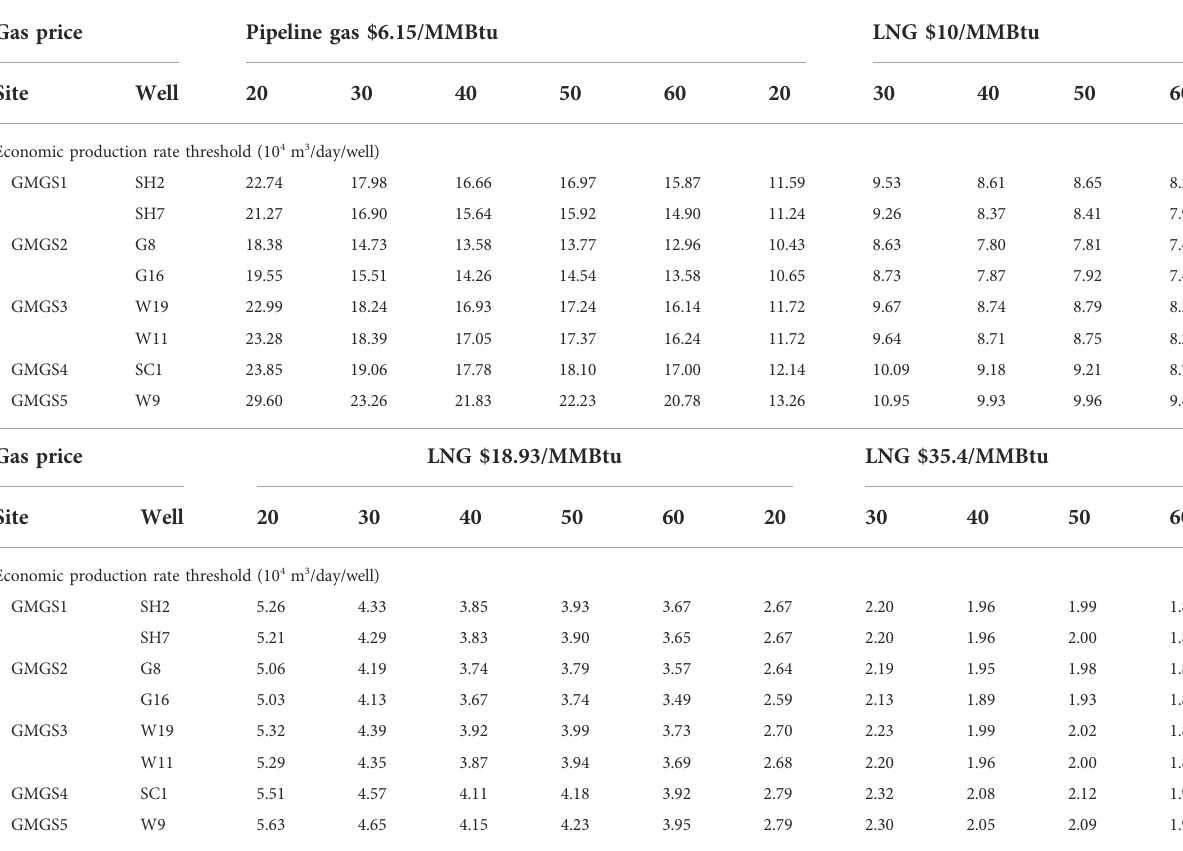
TABLE 4 Economic production rates for NGH industrial exploitation at different natural gas prices, changed with the number of production wells.